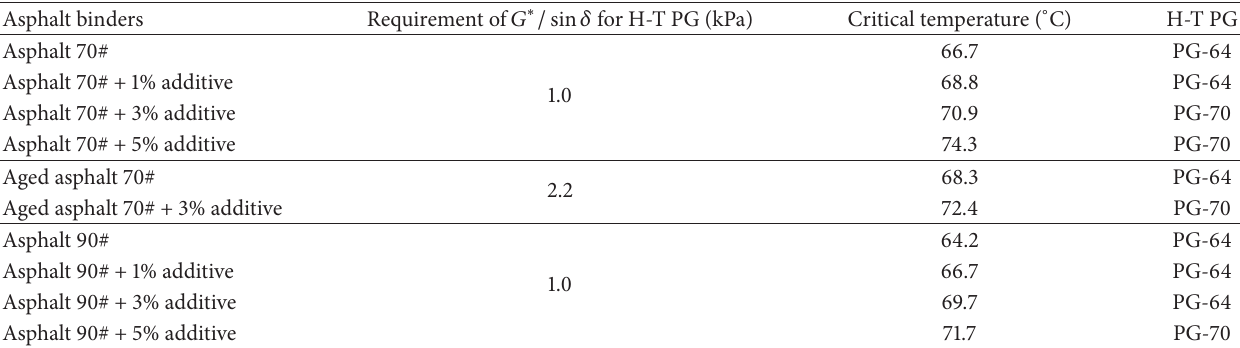
Table 6: Critical temperature and high-temperature performance